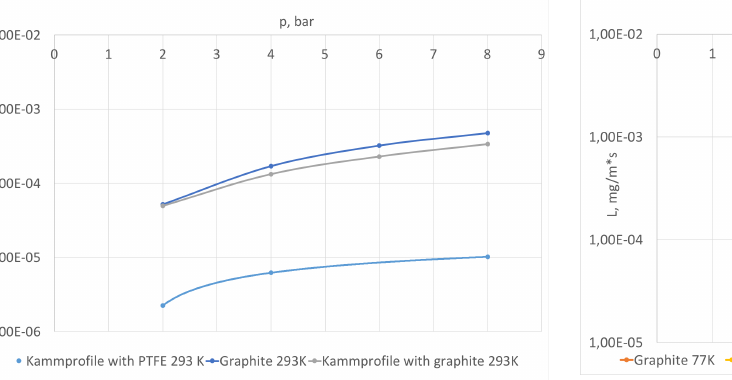
Figure 11: Characteristics of helium leakage from the flanged joint gasketed with particular gaskets at 77